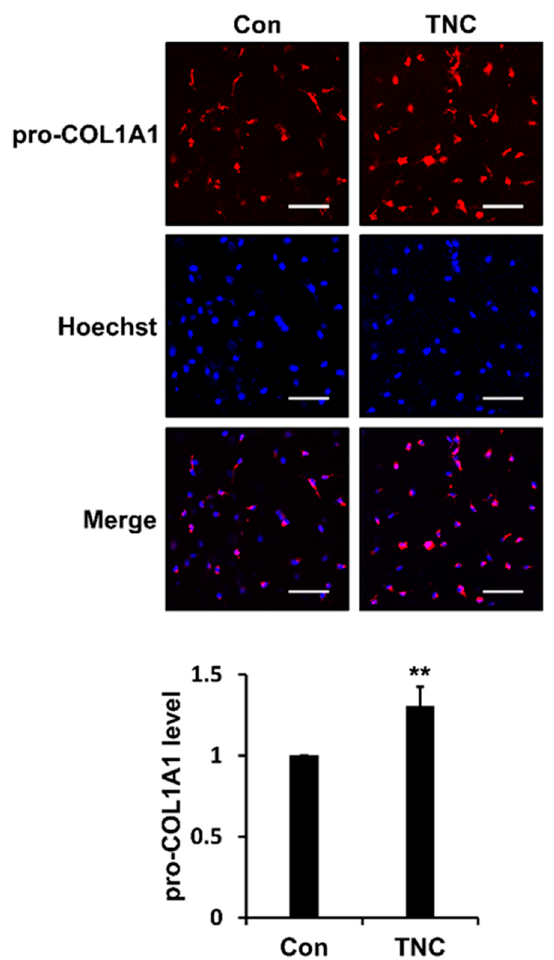
Figure 7. Effect of TNC on secretion of type I collagen during three-dimensional (3D) culture of fibroblasts. Foreskin fibroblasts embedded within a 3D type I collagen matrix without (Con) or with TNC (2 µg/mL) were incubated in serum-free DMEM for 24 h. The 3D matrix containing fibroblasts was stained with pro-COL1A1 primary antibody and Rhodamine Red-X secondary antibody, and with Hoechst 33258 for nuclear staining. Cells were analyzed by confocal fluorescence microscopy (×200). Relative pro-COL1A1 staining intensity normalized to nuclear staining intensity is shown in a graph. Each value represents the mean ± SD of three independent experiments. ** p < 0.01 vs. Con. Bar = 100 µm.